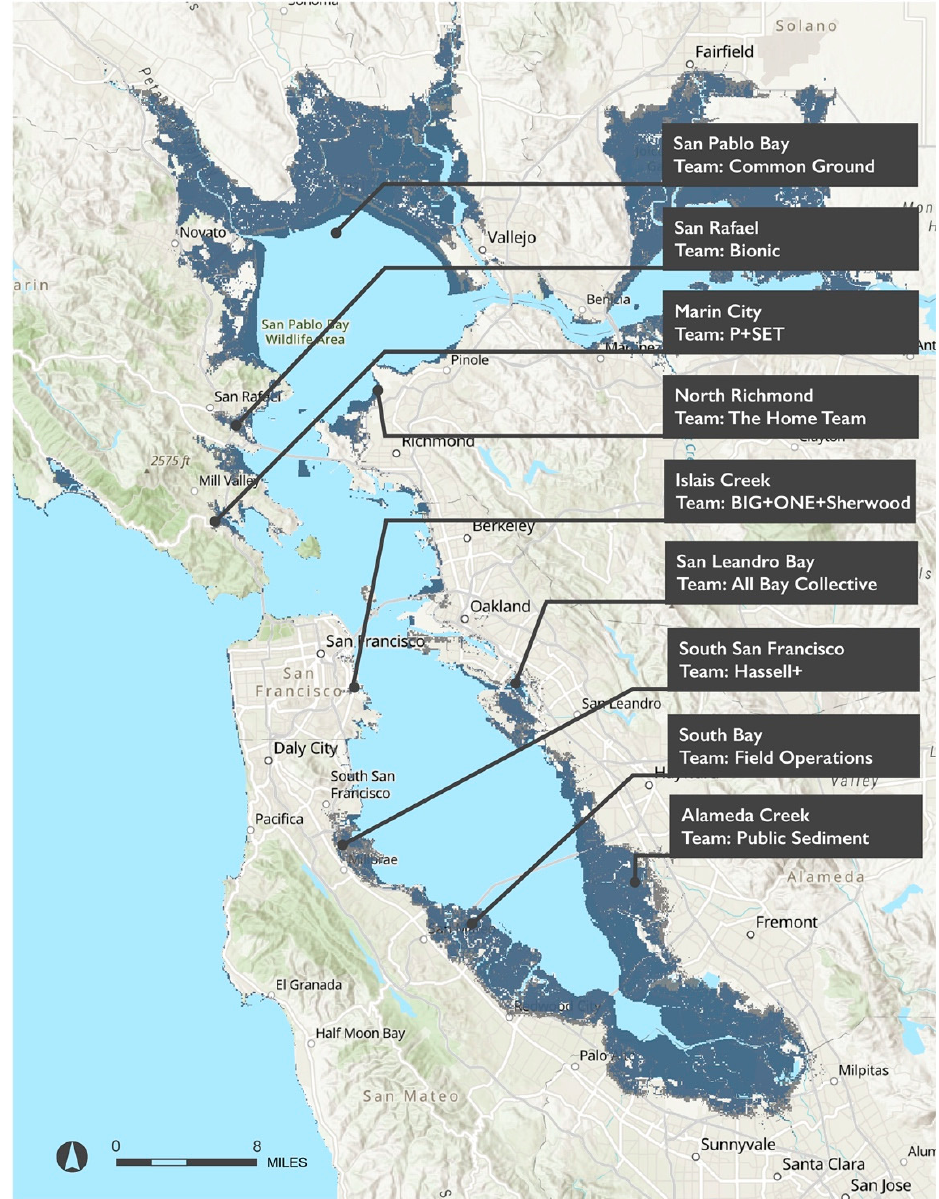
Figure 1. RbD project locations showing US Sea Level Rise Projections (Intermediate-High, 2090), San Francisco Bay Area, CA,